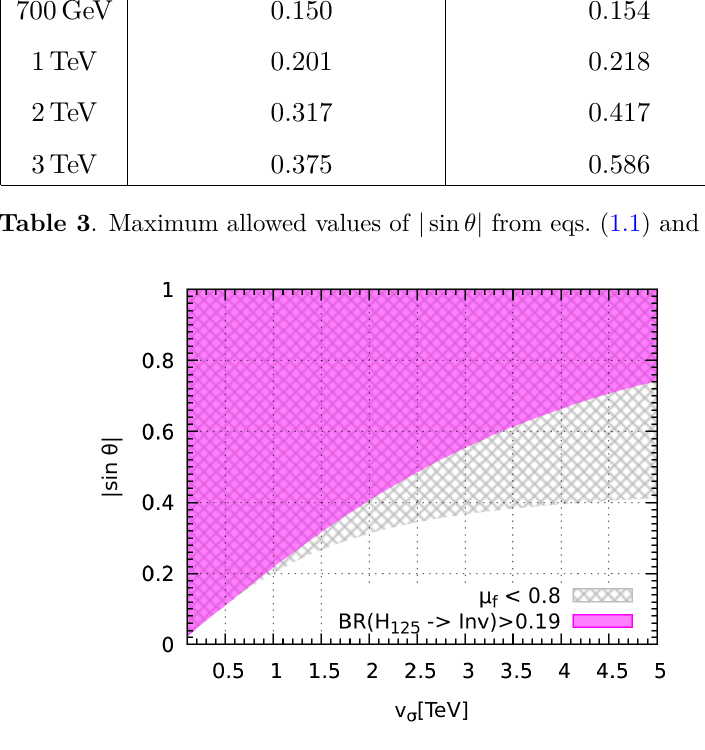
Figure 10 . The shaded areas on | sin θ | versus v σ are ruled out by the present limit on the invisible Higgs decay in eq. (1.2) (magenta) and the constraints on the signal strength parameter µ eq. (1.1)